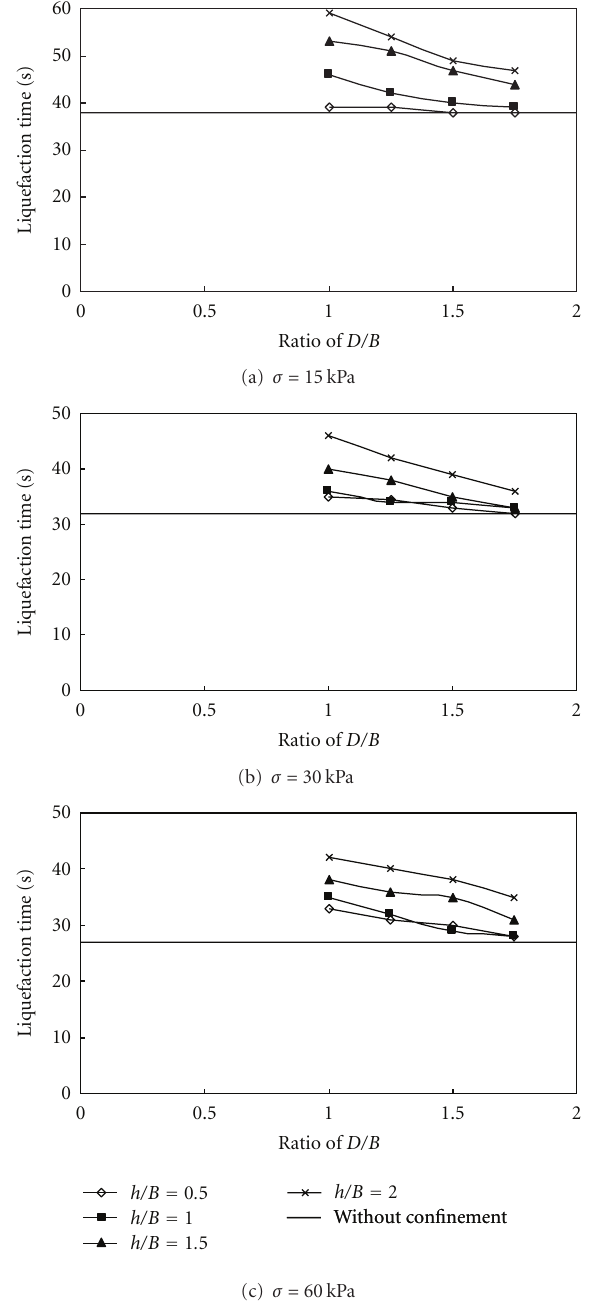
Figure 3: Variation of the liquefaction time with cell geometry at di ff erent